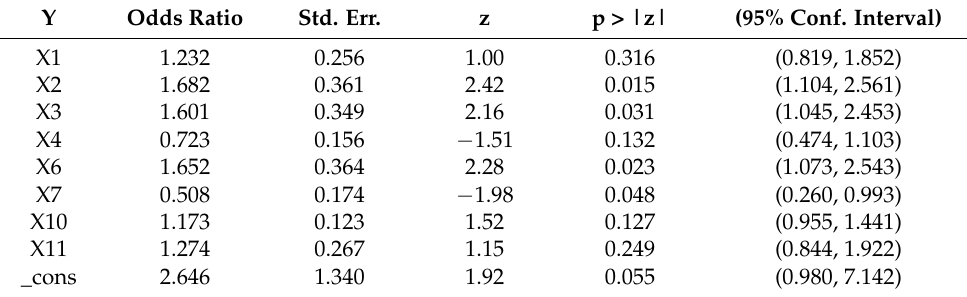
Table A6. The fifth step of stepwise logistic regression.